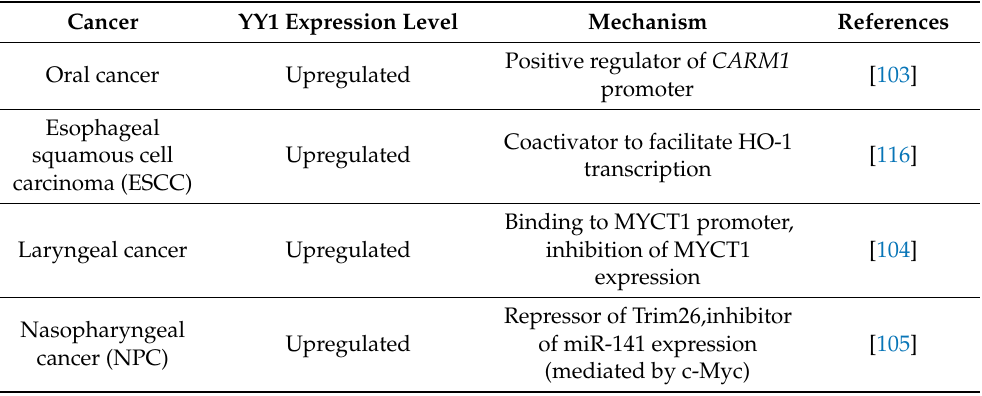
Table 1. YY1 expression in various HPV-related